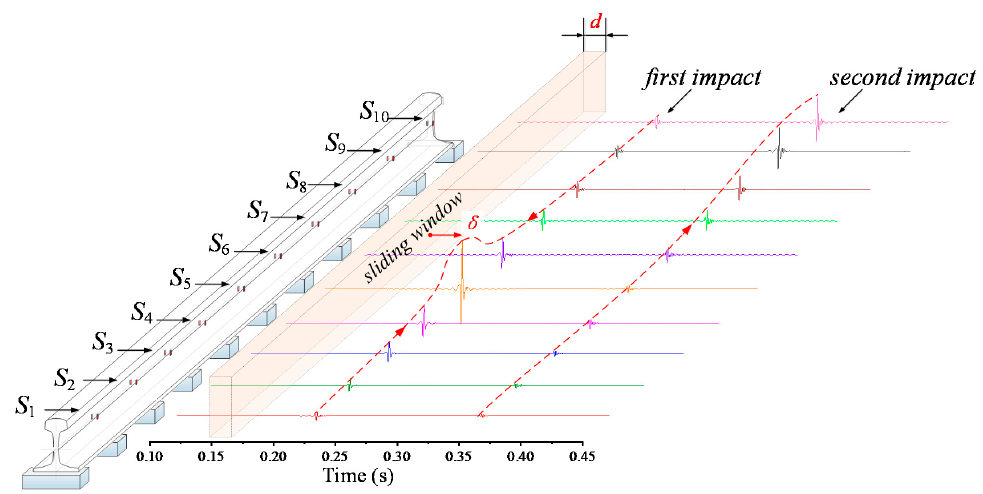
Figure 17. Processed signals after FFT high-pass filtering.